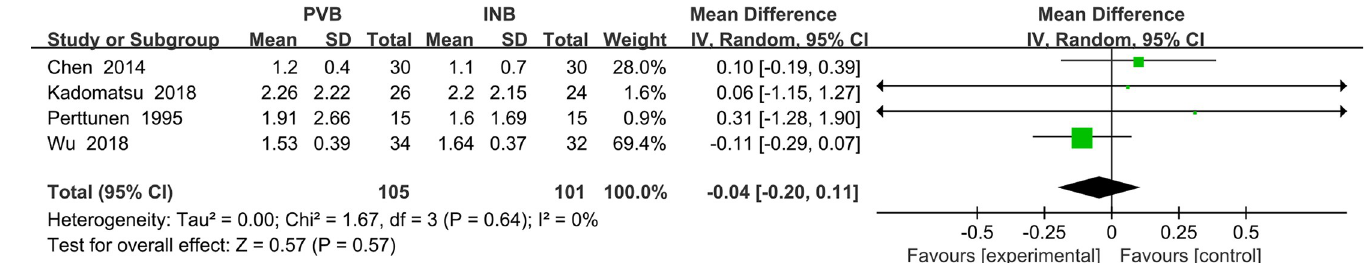
Fig 14. Forest plot of comparison: PVB VS INB. Outcome: VAS at rest at the first 48 h.